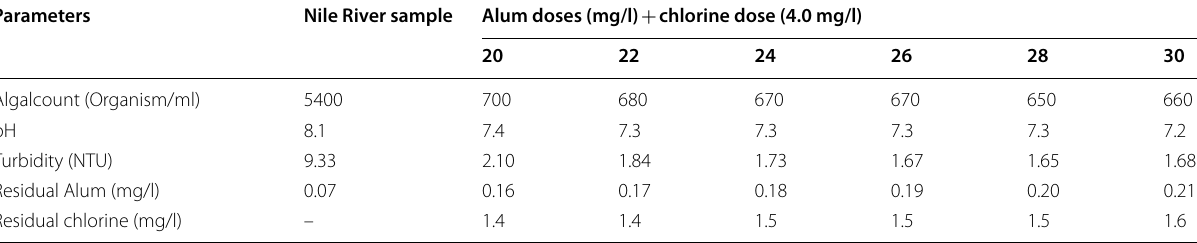
Table 2 Jar tests are based on alum doses and chlorine dose (4.0 mg/l) in Nile River samples Parameters